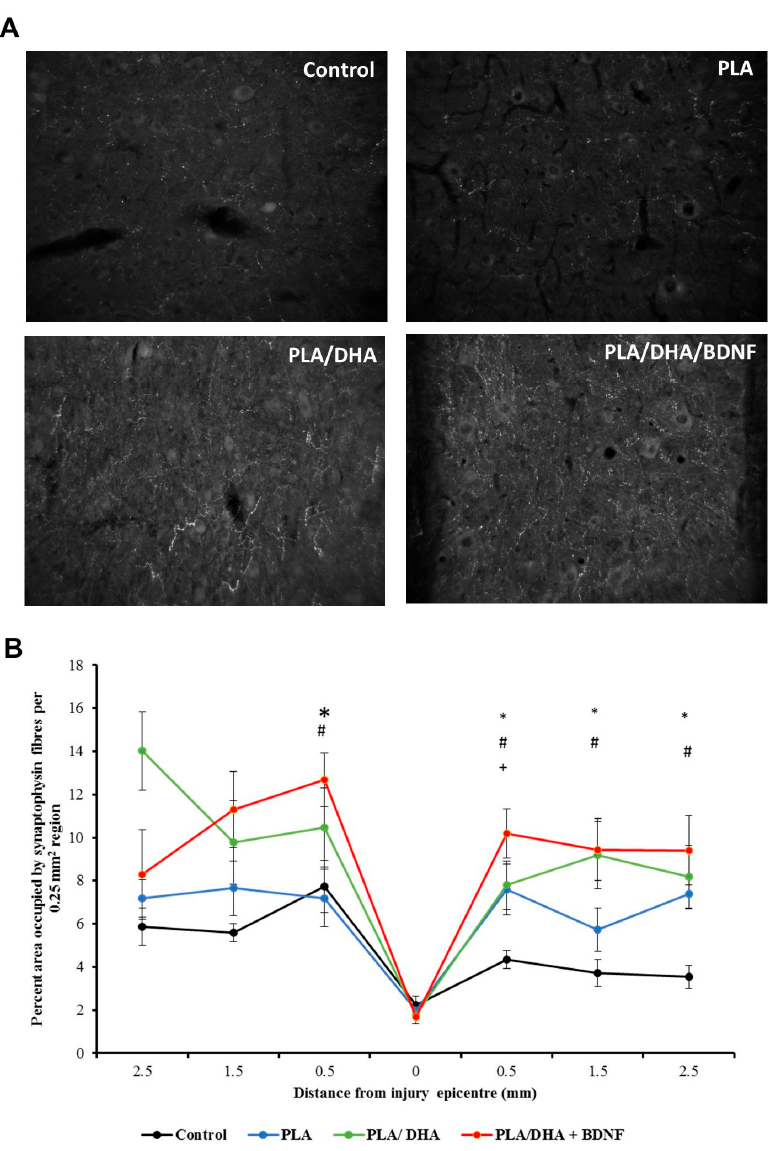
Figure 11. The immunolabeling of serotonin (5-HT) from the spinal cords of SCI rats after different treatments ( A ), and the area percentage occupied by the 5-HT fiber in the region rostral and caudal to the injury site ( B ). * p < 0.05 PLA/DHA/BDNF vs. control; # p < 0.05 PLA/DHA/BDNF vs. PLA; + p < 0.05 PLA/DHA/BDNF vs. PLA/DHA.